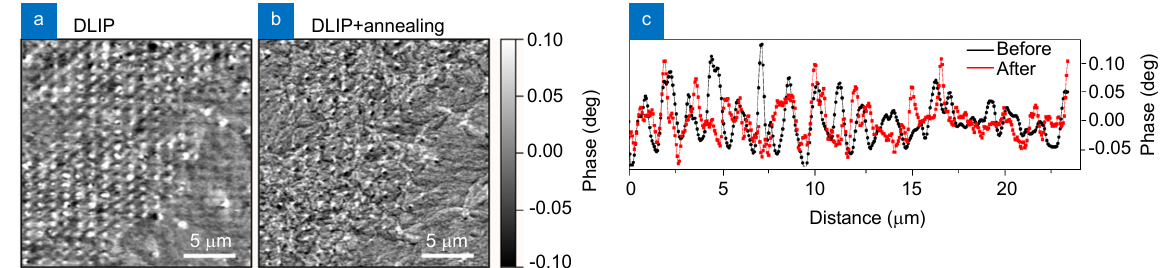
Fig. 6 | MFM images of the patterned Fe 60 Al 40 surface at the edge of the irradiated zone. The images were taken ( a ) before and ( b ) after thermal annealing in a furnace at T =770 K for one hour. ( c ) Cross section of the MFM image before and after thermal